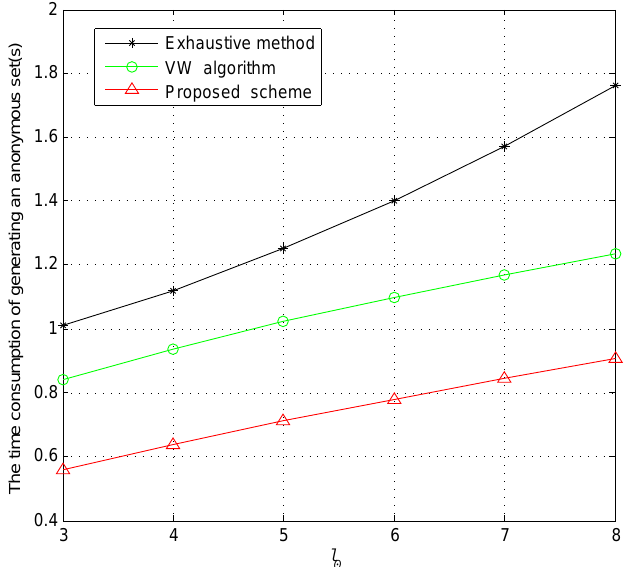
Figure 10. The average time computation of generating an anonymous set with the increase of l 0 . ( k 0 = 10, λ 0 =